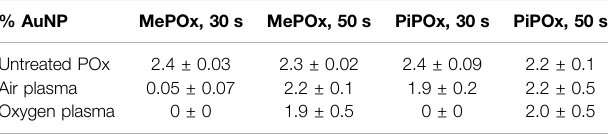
TABLE 1 | Atomic percentage of gold detected on MePOx and PiPOx surfaces after 3.5 h incubation with 68 nm AuNP solution, before and after 30 s of oxygen or air plasma treatment.